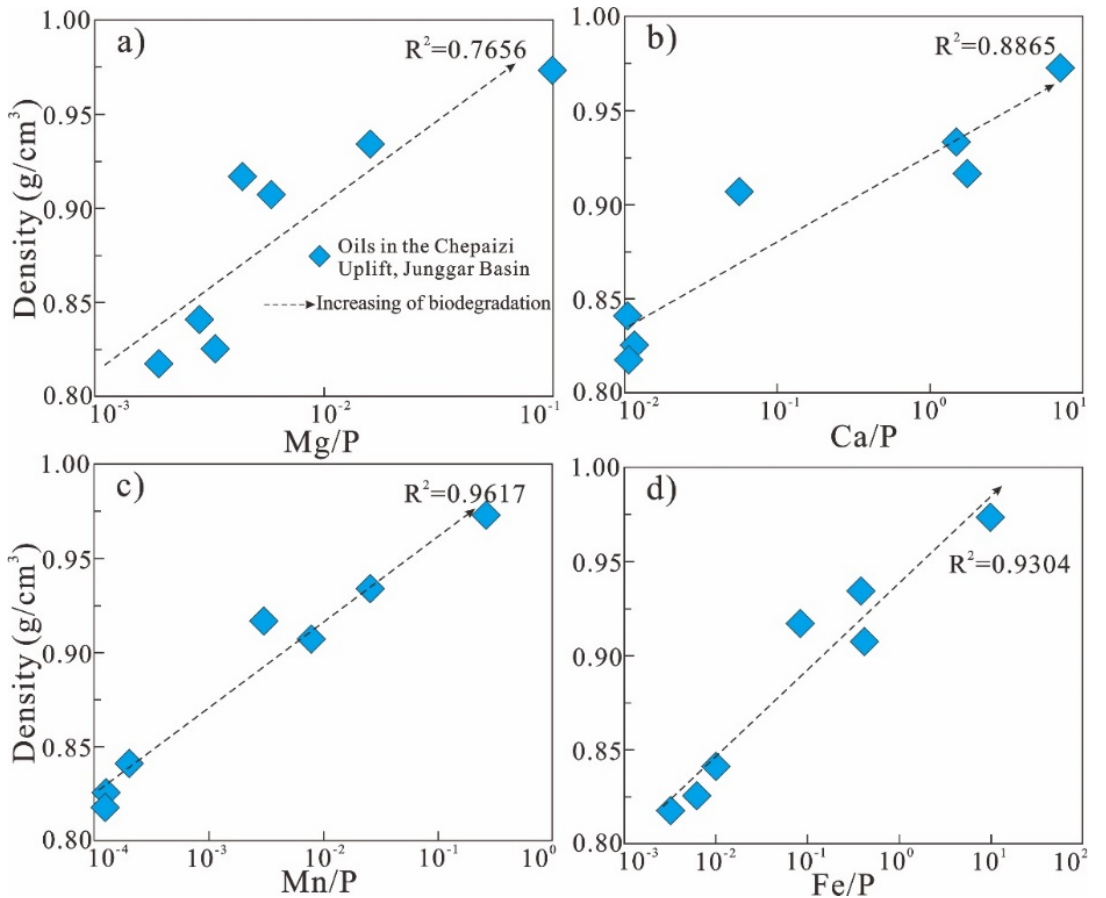
Figure 14. Cross plots of Mg/P ( a ), Ca/P ( b ), Mn/P ( c ) and Fe/P ( d ) ratios versus densities of oil samples from the Chepai Bulge in the western margin of the Junggar Basin.